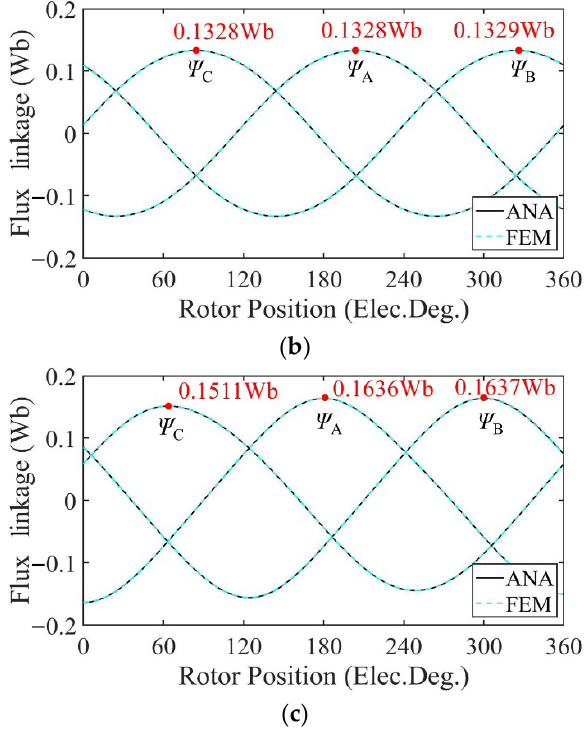
Figure 10. Flux linkage comparison. ( a ) Healthy; ( b ) uniform demagnetization; ( c ) partial demag- netization.